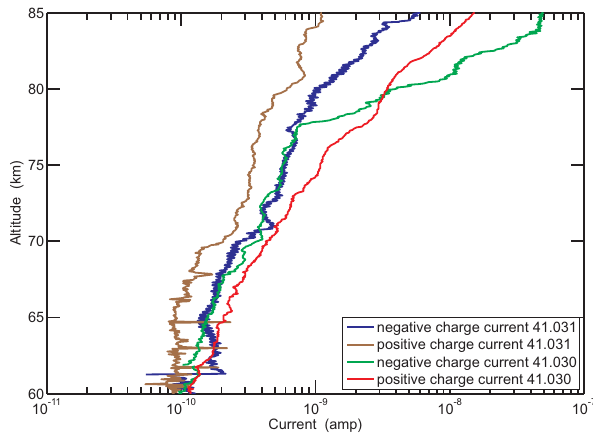
Fig. 18. Comparison of Langmuir ram probe currents for Flights 41.030 (24 January 2003, 20:50 UT) and 41.031 (28 Jan- uary 2003, 18:32 UT), Esrange, Sweden.